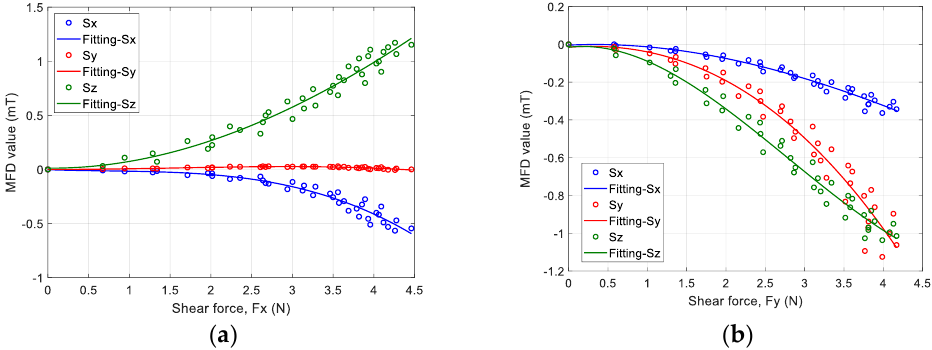
Figure 14. MFD value of 3-axis sensor output vs. shear force along the ( a ) x-axis and ( b ) y-axis.